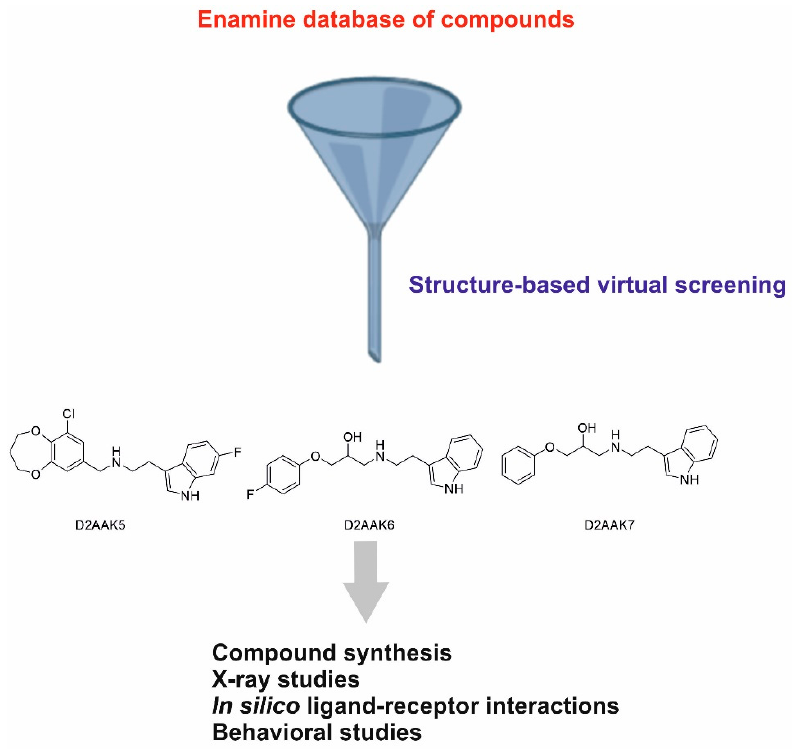
Figure 1. Rationale of the study and structural formulas of the studied